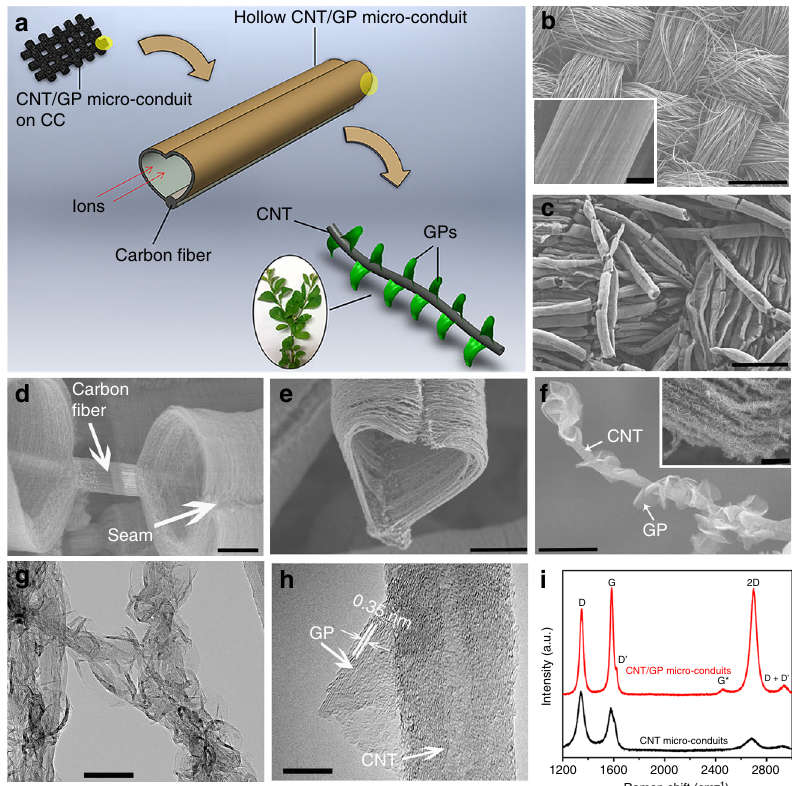
Fig. 1 Structural characterization of CNT/GP micro-conduits. a Schematic illustration of CNT/GP micro-conduits in a leaves-on-branchlet nanostructure on CC substrates for high-performance supercapacitor electrodes (Note that the yellow shaded areas in the schematic indicate the selected areas to be magni fi ed). b Bare CC substrate at low magni fi cation (inset shows the surface of a single carbon fi ber). c Uniform coverage of CNT micro-conduits on carbon fi bers at low magni fi cation. d A close-up of CNT micro-conduits on a carbon micro fi ber. e A CNT/GP micro-conduit in a heart shape. f A single CNT decorated with many GPs at high magni fi cation (inset shows GPs on CNT micro-conduit array walls). g TEM image of the hierarchical structure. h High- resolution TEM image of a petal emerging from a nanotube. i Comparative Raman spectra of CNT micro-conduits and CNT/GP micro-conduits on CC substrates. Scale bars: b 500 μ m (inset: 3 μ m), c 300 μ m, d 10 μ m, e 20 μ m, f 300 nm (inset: 2 μ m), g 100 nm, h 10